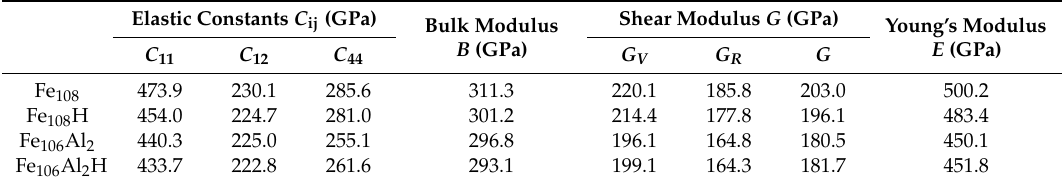
Table 3. The calculated elastic constants C ij , bulk modulus B , shear modulus G , Young’s modulus E (in GPa) of Fe 108 , Fe 108 H, Fe 106 Al 2, and Fe 106 Al 2 H in NM